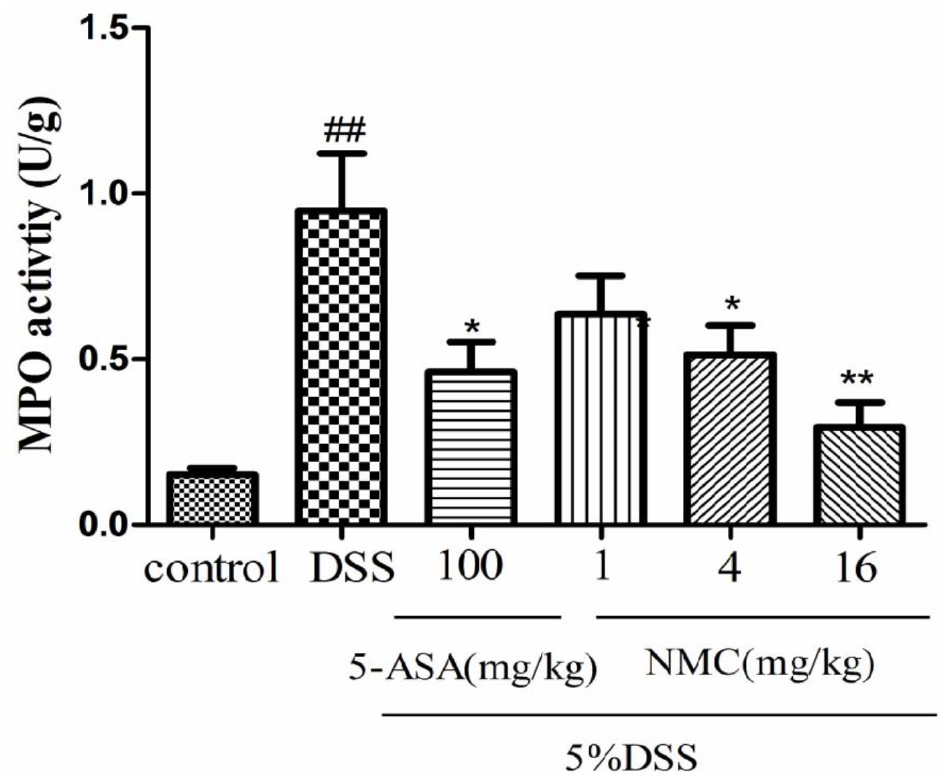
Figure 4. Effects of NMC on the MPO activity of colonic tissue from mice with DSS-induced colitis. Data are expressed as mean ( n = 10 per group) ± SEM. ## p < 0.01 compared with control group; * p < 0.05, ** p < 0.01 compared with the DSS-vehicle group.